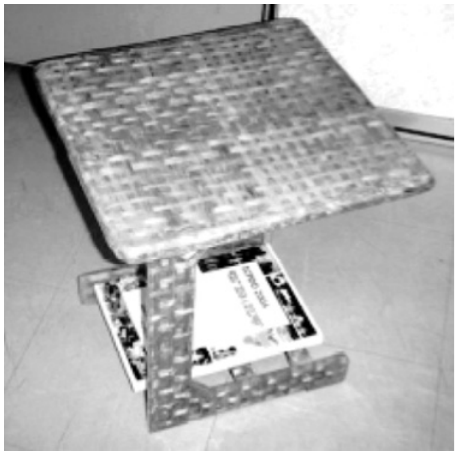
Figure 17: A banana pseudostem fiber epoxy composite multipur- pose table [50].